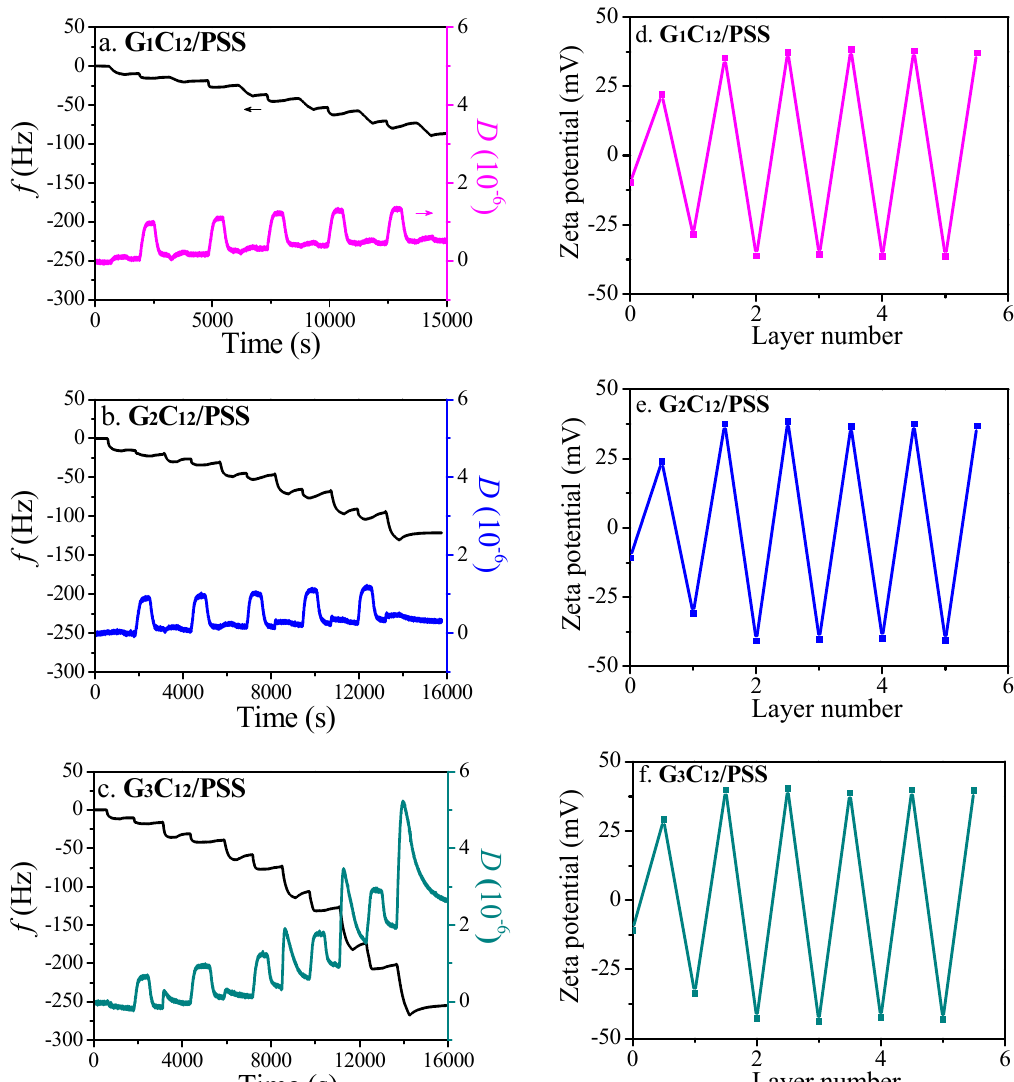
Figure 1. Shifts of frequency and dissipation as a function of time for multilayer assemblies of ( a ) G 1 C 12 /PSS, ( b ) G 2 C 12 /PSS, and ( c ) G 3 C 12 /PSS. Zeta-potentials as functions of the coating number on